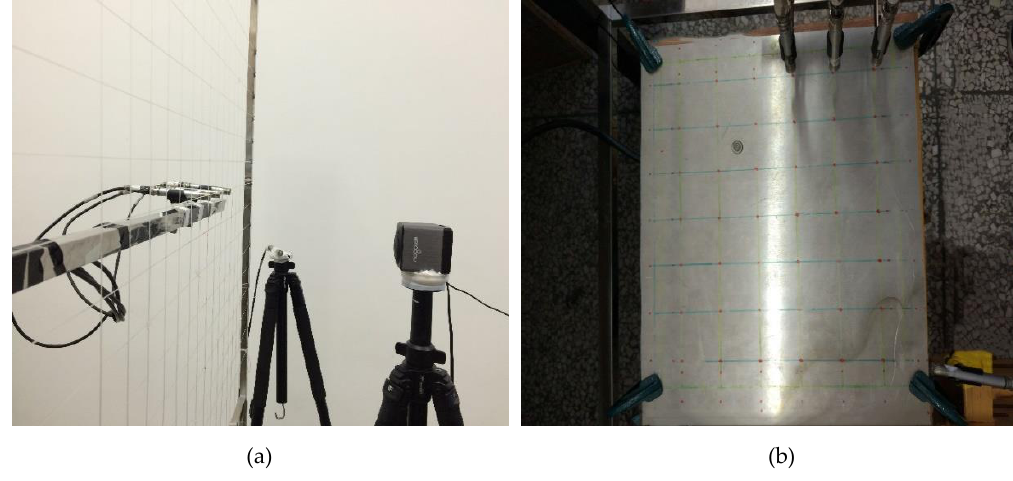
Figure 9. Experimental setup: ( a ) Single source; ( b ) Plate sound source.